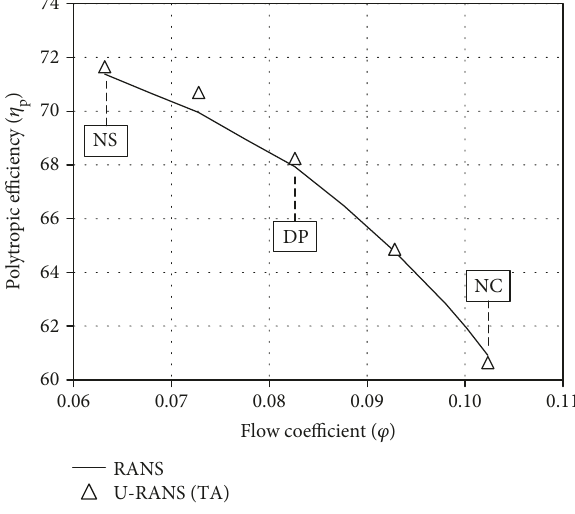
Figure 7: Polytropic e ffi ciency in the